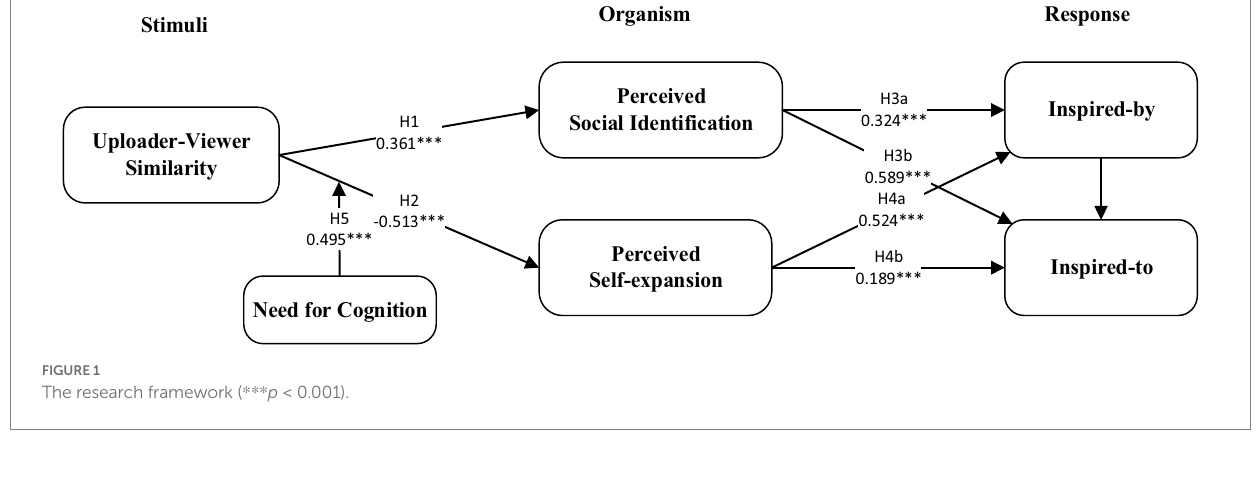
TABLE 5 Path analysis.